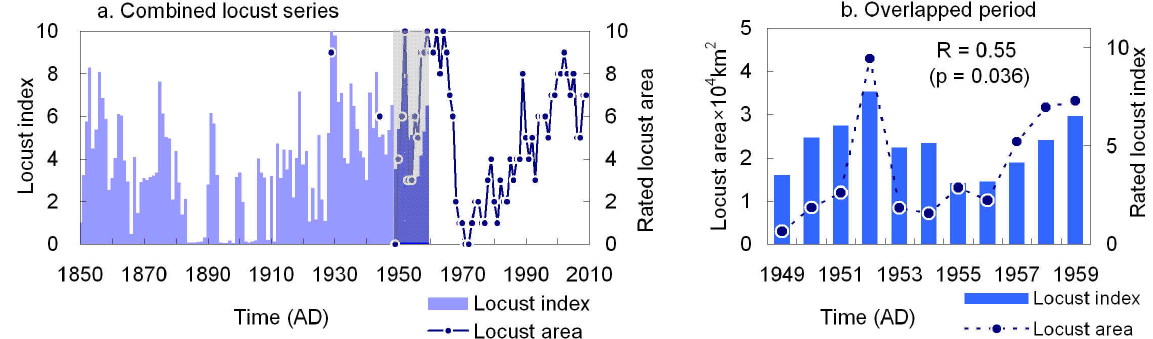
Fig. 2. Combined series of locust outbreak data for the EAP, including the severity index based on historical literature (blue bar) and the area index based on observed locust affected area (blue dotted line) (see main text for further details) (a) . The grey box in plot 2a enlarged to show the overlapping period 1949–1958AD, demonstrating that the two data series are significantly correlated (b) .